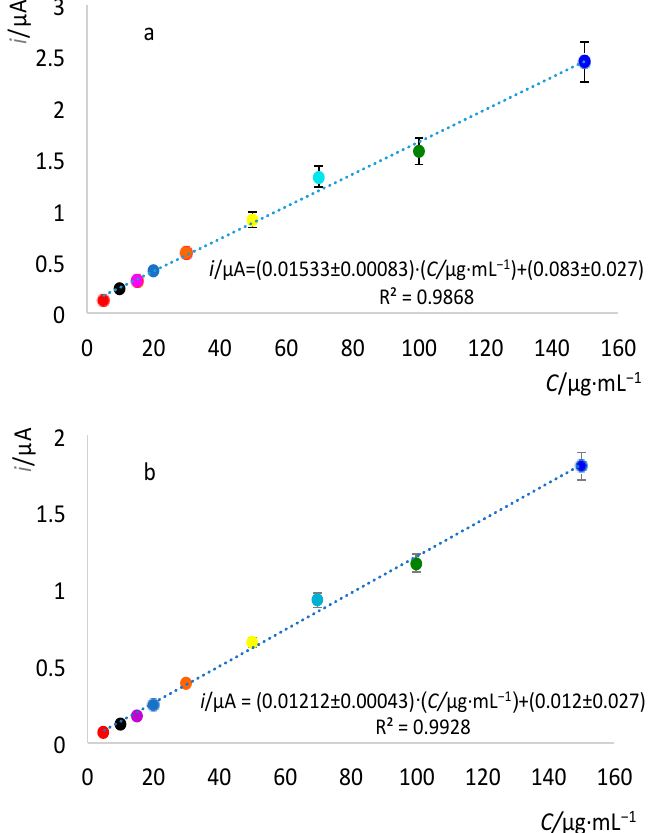
Figure 10. Calibration curve corresponding to DPV of AH-7921 ( a ) in ethanol/0.1 M lithium perchlorate and 0.10 M 2,6-lutidine; concentration range: from 5 µ g · mL − 1 to 150 µ g · mL − 1 . Calibration curve corresponding to DPV of U-47700 ( b ) in ethanol/0.1 M lithium perchlorate and 0.10 M 2,6-lutidine; concentration range: from 5 µ g · mL − 1 to 150 µ g · mL − 1 . Potentials are referred to Ag/AgCl, 3 M NaCl. Scan speed: 50 mV · s − 1 . Working electrode: glassy carbon, 2 mm diameter. The standard deviation is reported after the numerical value. Each point of the calibration curve corresponds to the voltammetric curve of the same color. Table 4. Calibration curves (DPV) for the considered compounds in ethanol/lithium perchlorate 0.1 M, and associated parameters. Standard deviation is reported after the numerical value. Each curve was obtained with 9 data points, from 5 µg·mL − 1 to 100 µg·mL − 1 . Peak potentials observed in DPV are also reported.